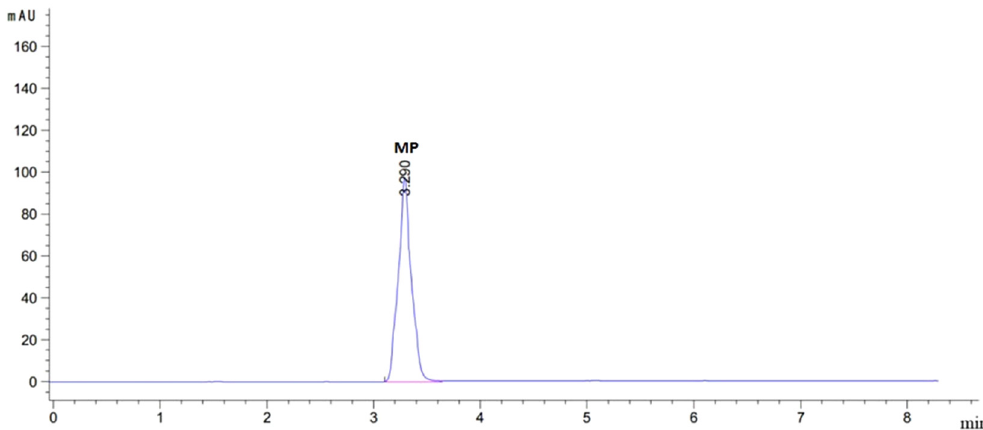
Figure 8: Chromatogram of the real sample.